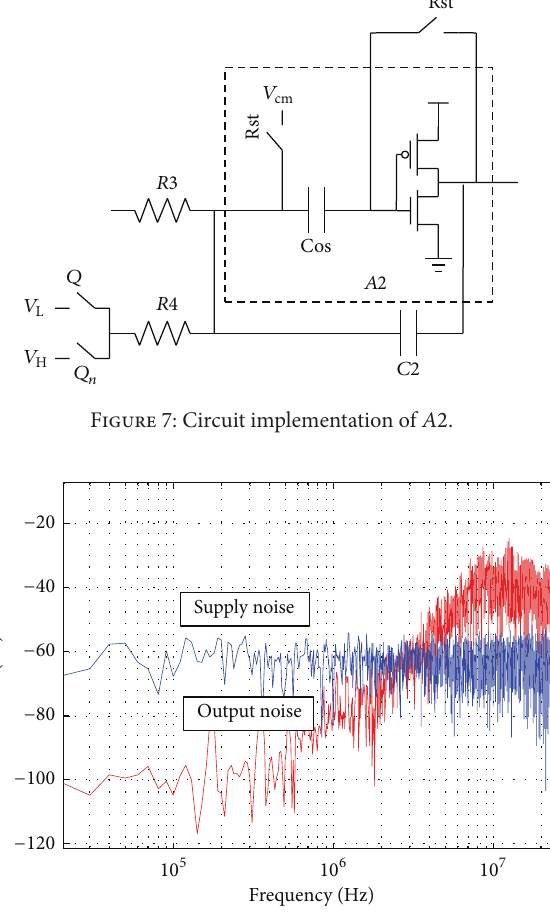
Figure 8: Simulated power supply noise